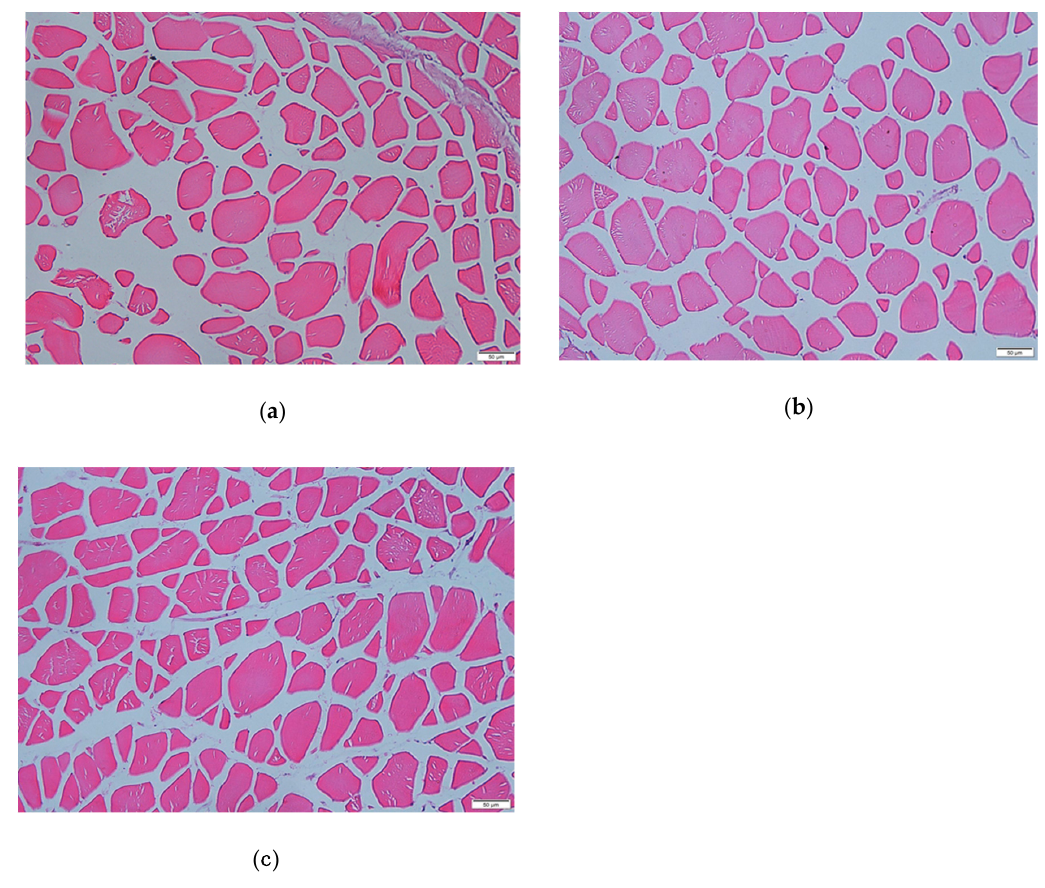
Figure 2. Microstructure of white muscle in cross-section (bars represent 50 µ m; ( a ), 10.0 g Leu kg − 1 diet group; ( b ), 25.0 g Leu kg − 1 diet group; ( c ), 40.0 g Leu kg − 1 diet group). Table 5. The muscle fiber diameter (DI, µ m) and density (DE, n / mm 2 ) of hybrid catfish fed diets containing graded levels of Leu (g kg -1 ) for 8 weeks.